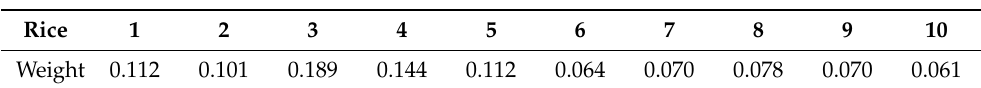
Table A16. Weight of each criterion for